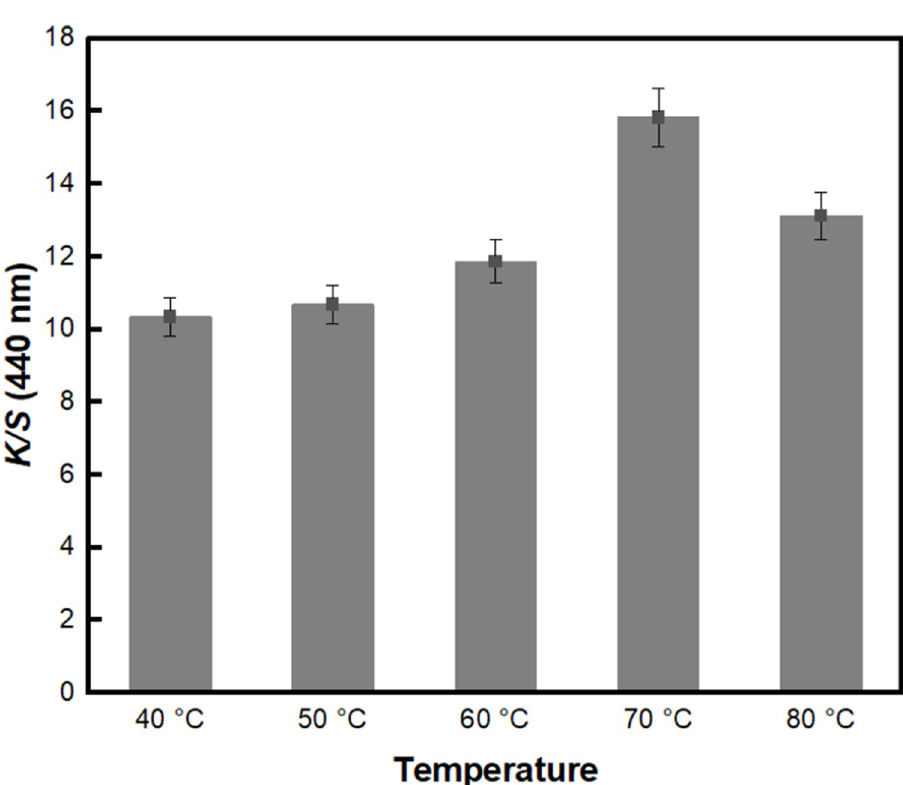
Fig 2. The K/S values of BC-COF bio-leather at 440 nm with varied dyeing temperature from 40˚C to 80˚C (Extraction conditions: Liquor ratio of 1:10 (w/v), coffee at an amount of 200 wt% BC, 90˚C, 1 h; dyeing conditions: Fabric-to-liquor ratio of 1:10 (w/v), 30